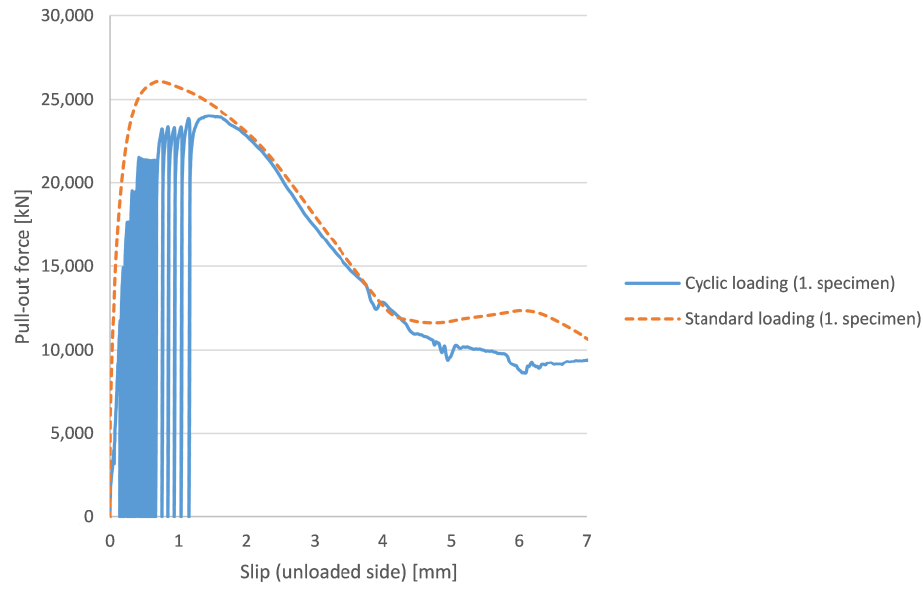
Figure 14. Comparison of standard and cyclic loading force vs. slip of NWAC.